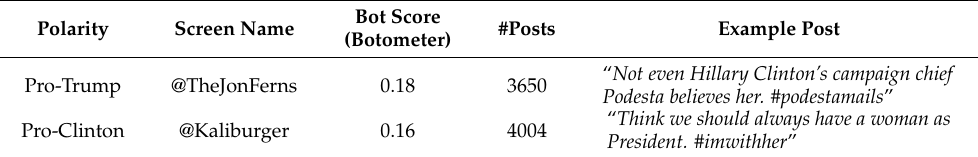
Table 5. Description of the most prolific real accounts supporting each